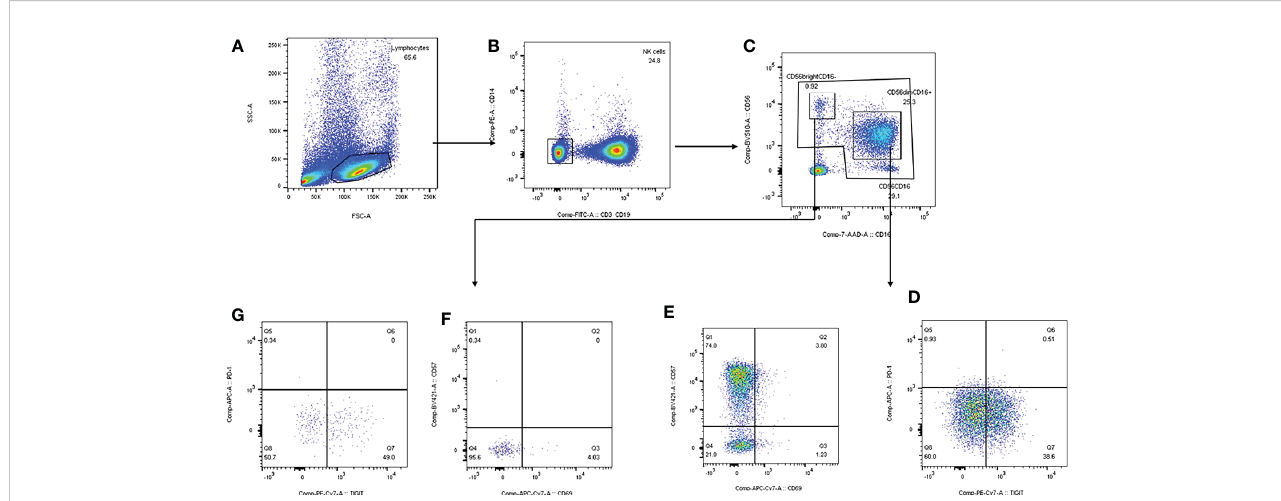
FIGURE 2 Strategy of subgroup gate and analyzation on FlowJo software. (A) mononuclear cells were separated according to side scatter and forward scatter. (B) We draw the gate of NK cells based on CD3/CD19-FITC and CD14-PE. (C) CD56 dim CD16 + and CD56 bright CD16 - were separated by CD16-7-AAD and CD56-BV510. (D, E) CD69 + CD56 dim , CD57 + CD56 dim , TIGIT + CD56 dim , PD-1 + CD56 dim were delineated by TIGIT-PE-Cy7, PD-1-APC, CD69-APC-Cy7 and CD57-BV421. (F, G) CD69 + CD56 bright , CD57 + CD56 bright , TIGIT + CD56 bright , PD-1 + CD56 bright were delineated by TIGIT-PE-Cy7, PD-1-APC, CD69-APC- Cy7 and